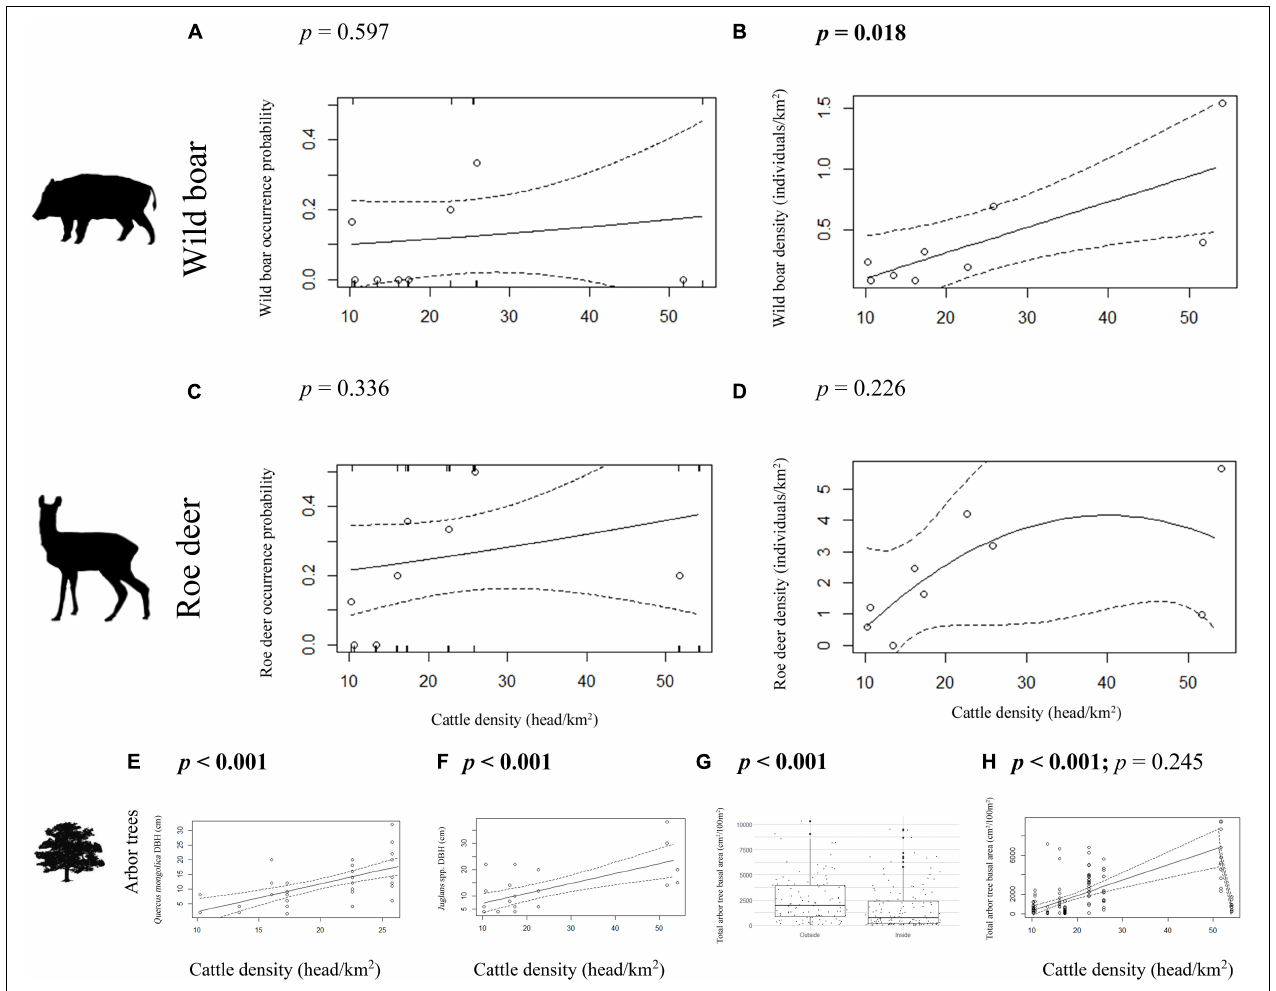
FIGURE 3 | Wild boar (A,B) and roe deer (C,D) occurrence probability (A,C) and density (B,D) , and Quercus mongolica DBH (E) , Juglans spp. DBH (F) , and total arbor tree basal area (H) inside forest cattle grazing enclosures in response to cattle density. Total tree basal area outside (left plot) and inside (right plot) forest cattle grazing enclosures is also shown (G) . Note that we assume some level of free-roaming cattle grazing outside enclosures (see section “Materials and Methods”). p -values in bold indicate statistical significance ( p < 0.05). The segmented model (H) shows the p -value of the first slope (left) and the difference between the first and second slope (right). Note the scales of x and y